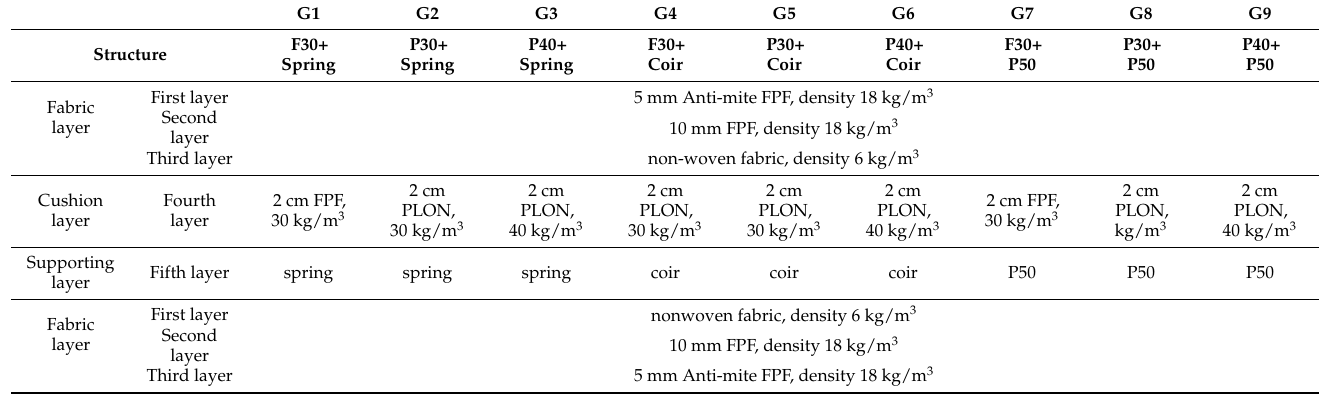
Table 1. Mattress structure configurations of different mattress groups.